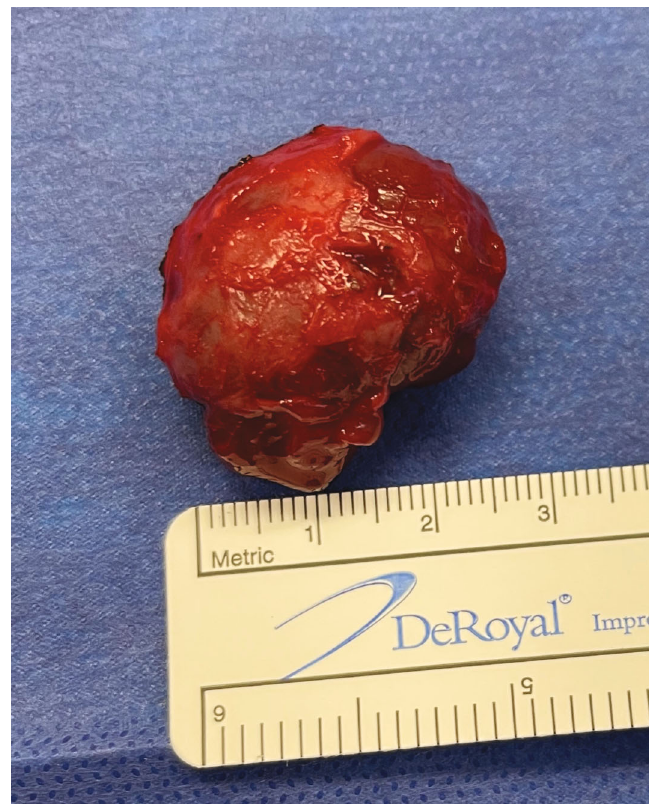
Figure 2: Gross specimen of the AA that was removed measuring about 2.75cm in diameter.